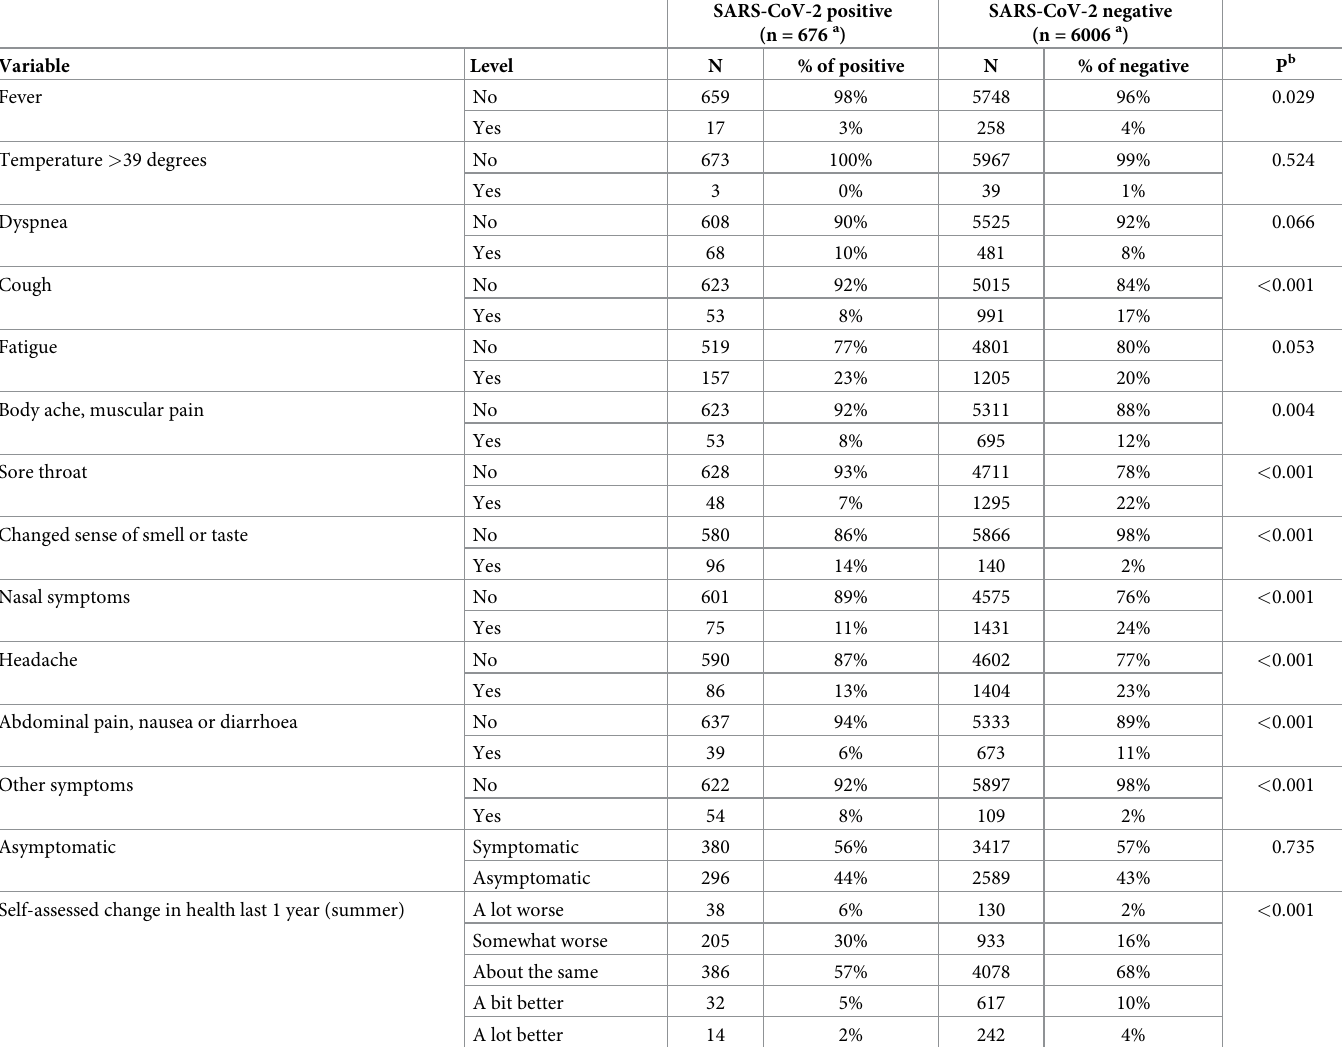
Table 3. Follow-up symptoms the last three weeks before completing the three-month follow-up